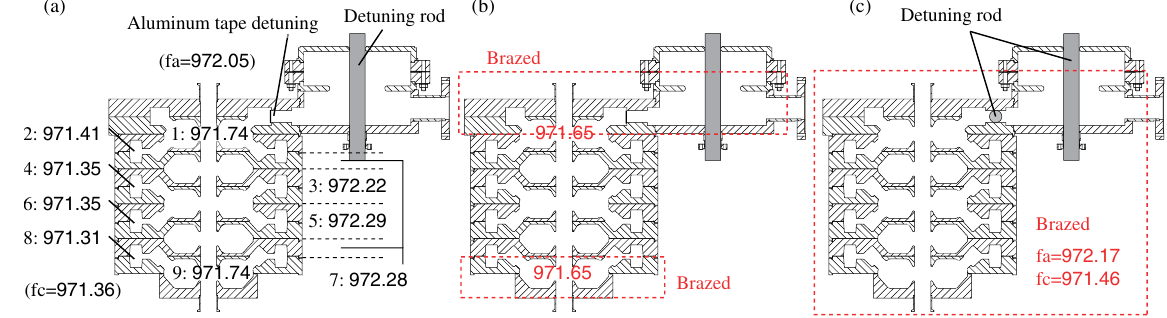
FIG. 6. Variations in the cell frequencies for accelerating tank 1 due to the brazing process. The dotted red lines surround the brazed parts. The bridge tank and side-coupling cell are detuned with a detuning rod or an aluminum tape with a width of 4 mm. (a) The cell frequencies just after frequency tuning with an ultraprecision lathe. The accelerating-mode frequency ð fa Þ and coupling-mode frequency ð fc Þ are evaluated by averaging the accelerating cells and the coupling cells, respectively. (b) The cell frequencies just after the first brazing. (c) The accelerating-mode and coupling-mode frequencies after the final brazing.